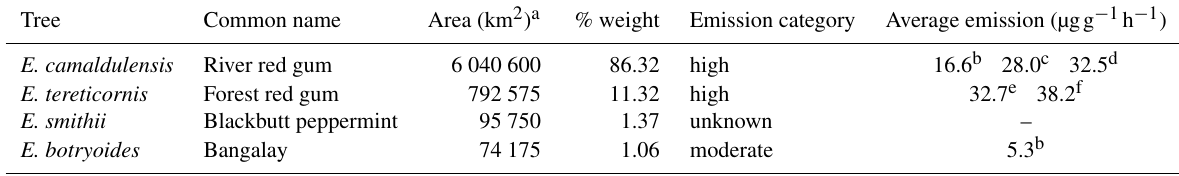
Table 1. Geographic range size of each Eucalyptus species in Australia and the isoprene emission rate based on dry leaf weight.